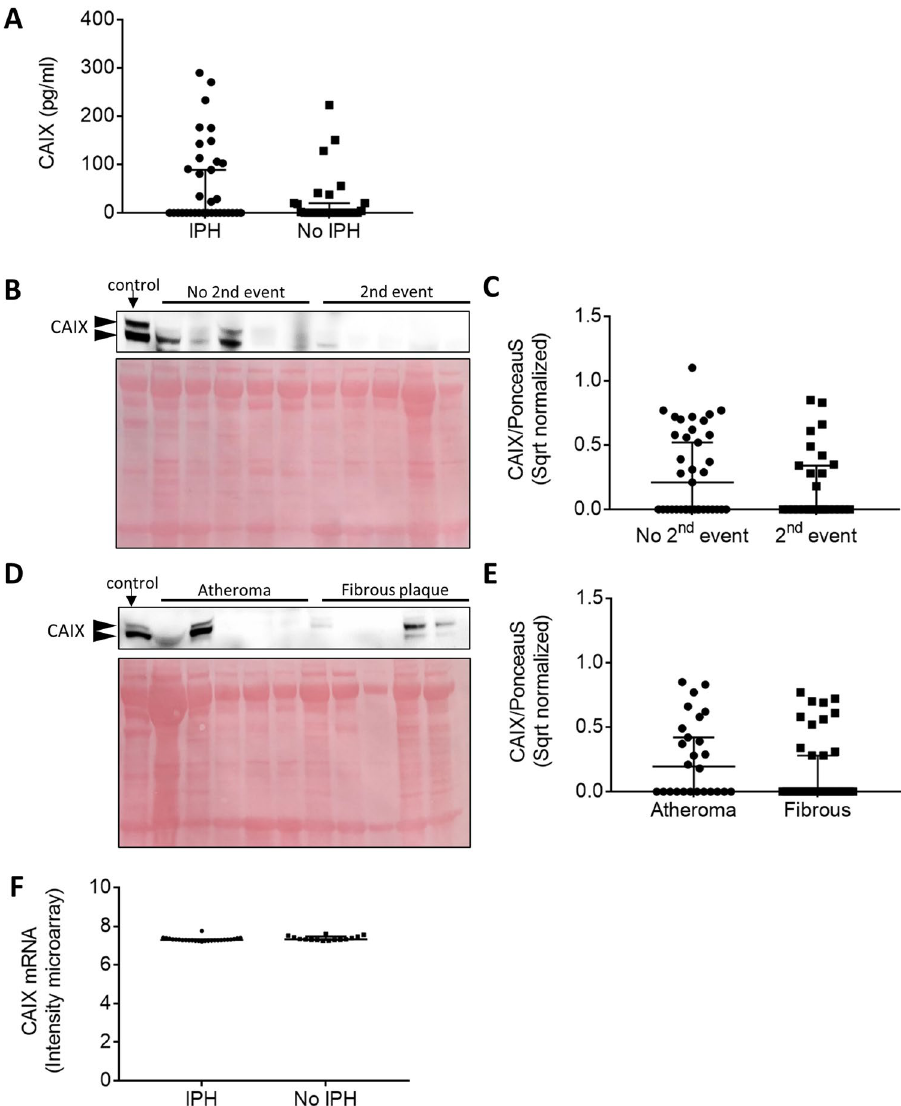
Figure 4. sCAIX and plaque resident CAIX was not changed in patients with events or plaque type. ( A ) sCAIX values in human carotid plaques with or without IPH from the MaasHPS cohort. ( B ) Representative cropped western blot and (C) quantification of CAIX protein in human carotid plaque lysates with (n = 27) and without a second event (n = 35) derived from Athero-Express biobank study. CAIX protein intensity is corrected for protein levels by ponceau S, and square root (sqrt) normalized. ( D ) Representative cropped western blot and ( E ) quantification of CAIX protein in atheromatous (26) and fibrous (n = 33) human carotid plaque lysates derived from Athero-Express biobank study. Arrow heads indicate two bands known to correspond to CAIX, 2nd, second. Full length western blots can be found in Supplemental Figures S3 and S4, ( F ) CAIX mRNA as derived from microarray analysis in human carotid plaques with or without IPH derived from the MaasHPS